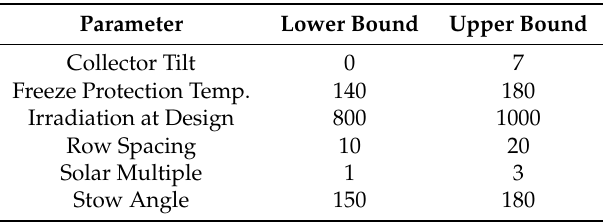
Table 1. Decision variables and their bounds.